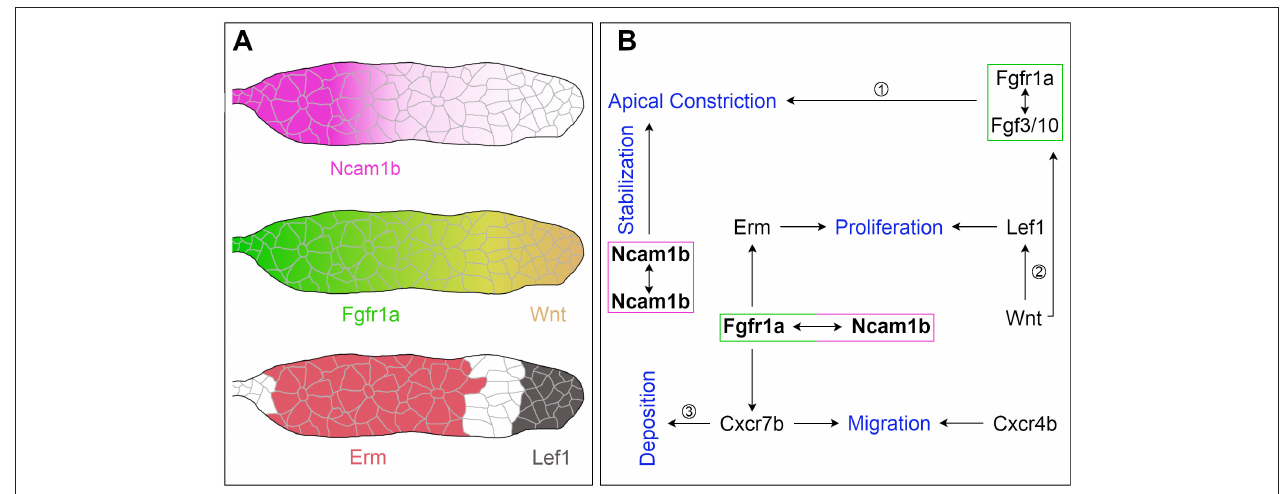
FIGURE 7 | The function of Ncam1b during posterior lateral line development. (A) Expression patterns of Ncam1b, Fgfr1a, Wnt, Erm and Lef1 in the pLLS primordium. (B) Interaction of Ncam1b with Fgfr1a results in activation of the transcription factor Erm, which is involved in cell proliferation in the Trailing-Zone of PrimI. The Ncam1b/Fgfr1a interaction also initiates the expression of the chemokine receptor Cxcr7b, which is necessary for directional migration of the PrimI and for proneuromast deposition. Wnt signaling controls proliferation in the Leading-Zone via Lef1. In addition, it triggers Fgf signaling in the Trailing-Zone, which initiates apical constriction during formation of proneuromasts. Proneuromasts are stabilized by homophilic Ncam1b binding in trans. (Data related to ‹ Lecaudey et al. (2008) › Aman et al. (2011) fi Aman and Piotrowski